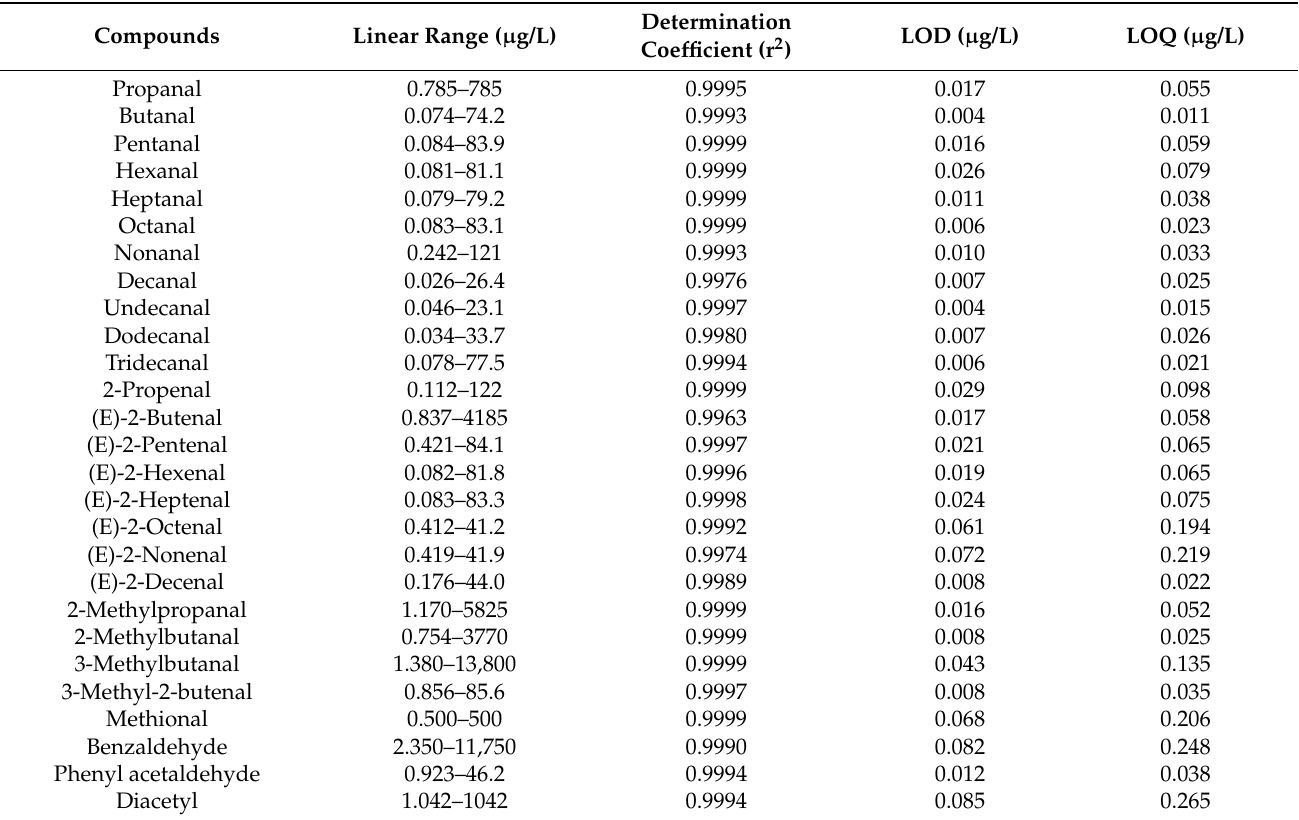
Table 3. Linear range, determination coefficient, limit of detection (LOD), and limit of quantitation (LOQ) of the proposed